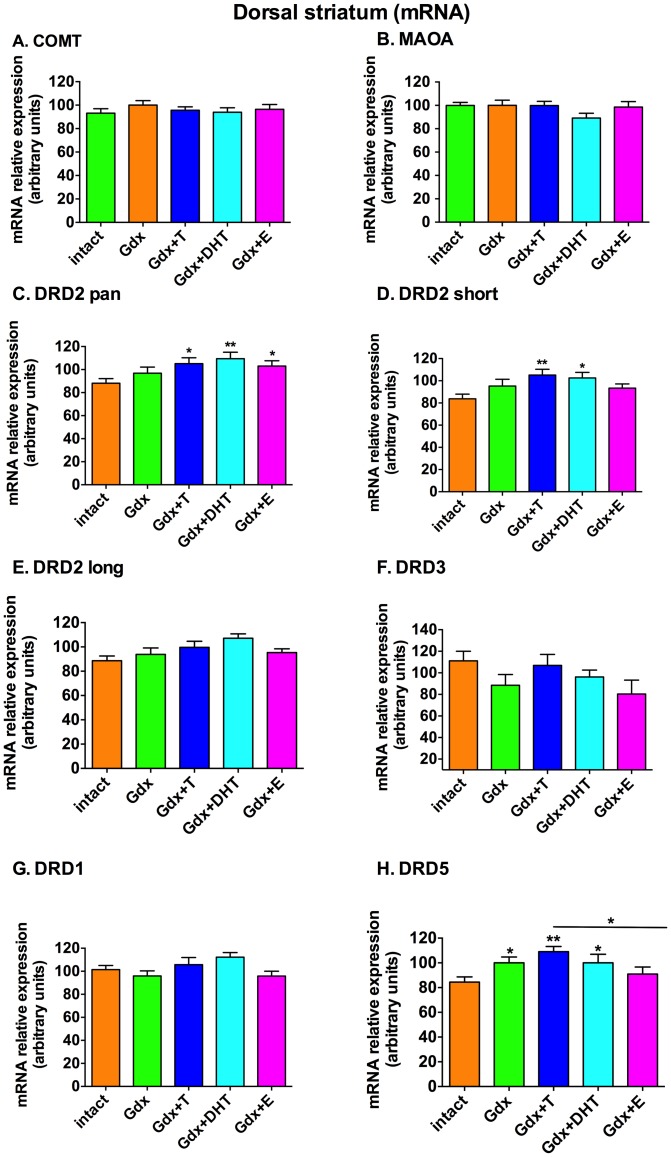
Effect of gonadectomy and sex steroid replacement on dopamine metabolic enzyme and dopamine receptor mRNA expression in the dorsal striatum of adolescent male rats.There was no effect of treatment group on mRNA expression of COMT (A) or MAOA (B). (C) DRD2 pan mRNA was increased by testosterone, DHT and 17β-estradiol replacement relative to the Intact group. (D) DRD2 short mRNA was increased relative to the Intact group by testosterone and DHT replacement but not by17β-estradiol replacement. (E) There was a trend for treatment group to change DRD2 long mRNA expression (F =  2.36, df  =  (4,65), p = 0.063). There were no statistically significant sex steroid-related changes in (F) DRD3 mRNA (F = 1.62, df  =  (4,65), p = 0.18) or (G) DRD1 mRNA (F = 2.10, df  =  (4,65), p = 0.015) (H) DRD5 mRNA expression was increased relative to the Intact group by Gdx, testosterone and DHT replacement but not by 17β-estradiol replacement. * denotes comparison with intact, * p<0.05, ** p<0.01, n = 12–16/group.